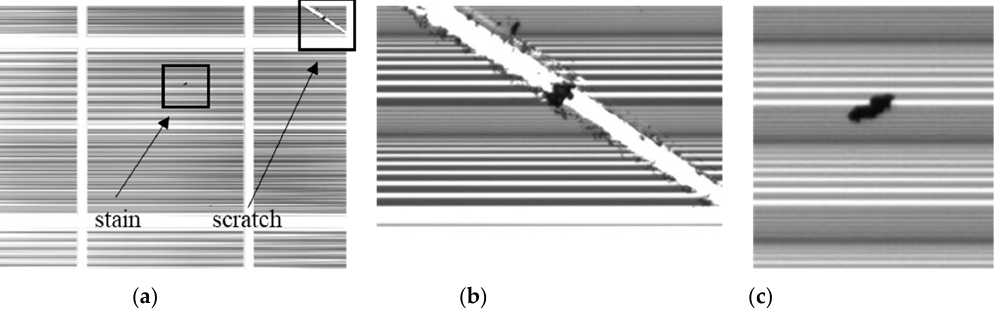
Figure 1. Defects in the striped images include: ( a ) scratches and stains (marked with boxes). ( b ) Enlargement of a scratch. ( c ) Enlargement of a stain.